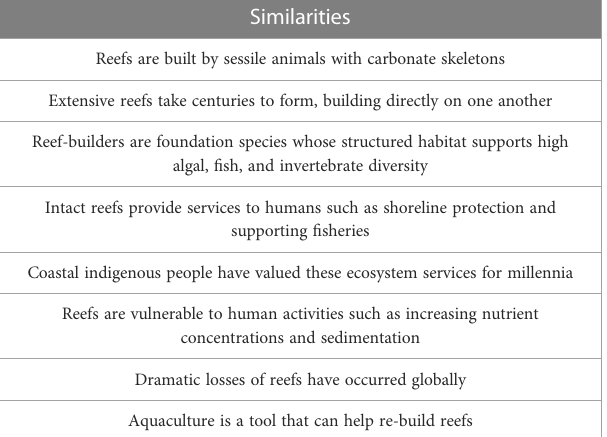
TABLE 1A Similarities and differences between oysters and corals affect aquaculture approaches, methods, and success.